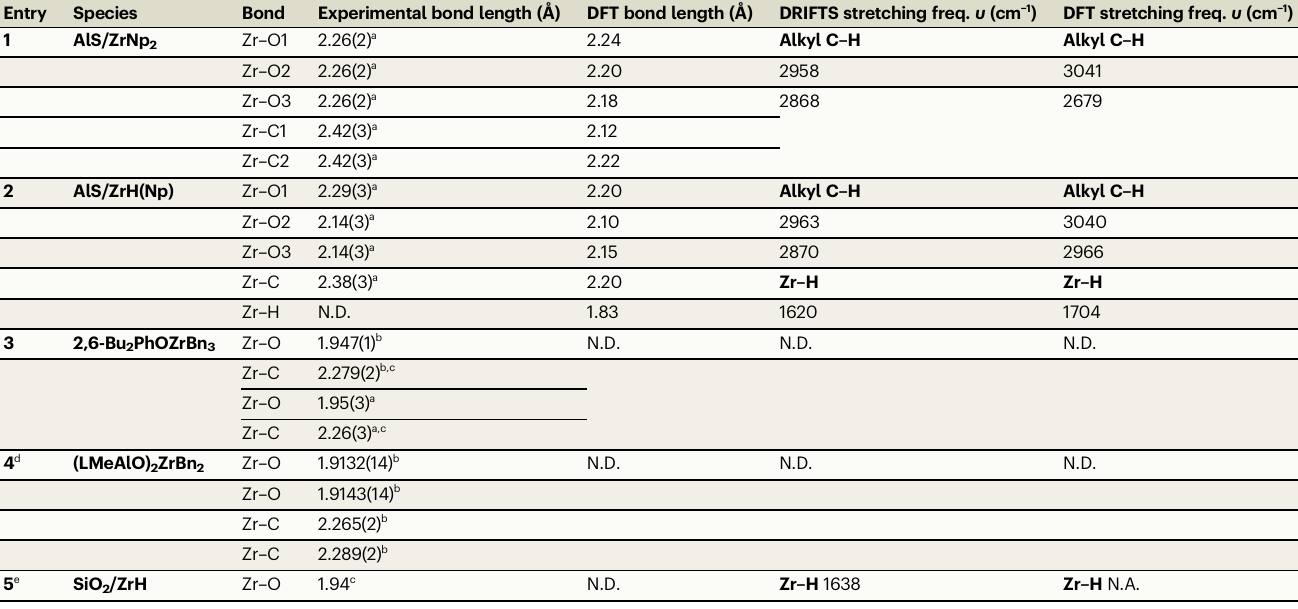
Table 2 | Experimental EXAFS and DRIFTS structural data for AlS/ZrNp 2 and AlS/ZrH(Np), and their DFT computed metrical